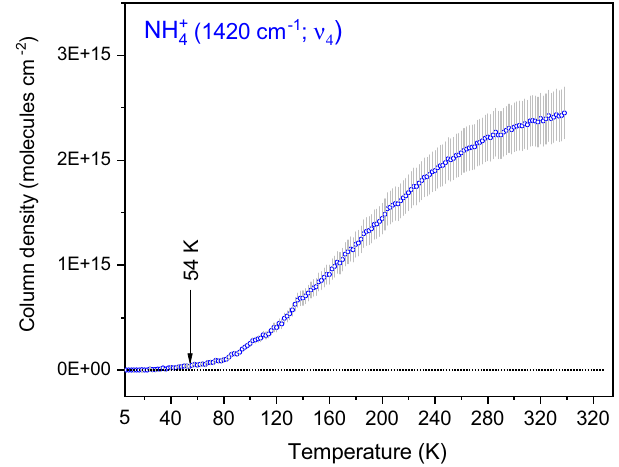
Fig. 3 Evolution of column density of NH 4 + ion. Column density at 7.04 µ m (1420cm − 1 ; ν 4 ) band was measured as a function of temperature during the TPD (temperature programmed desorption) phase of ammonia-coated montmorillonite. Column density was calculated using the calculated absorption co-ef fi cient (1.50×10 − 16 cm molecule − 1 ) of bending mode ( ν 4 ) of NH 4 + ion reported in the reference 49 . The vertical error bars indicate standard deviation